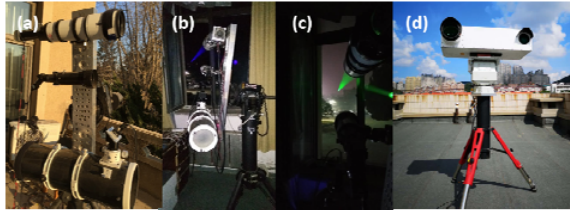
Fig. 1. Atmospheric remote measurements by employing (a) 808 nm SLidar system, (b) 450 nm SLidar system, (c) 520 nm SLidar system and (d) a portable unmanned 808-nm SLidar system.